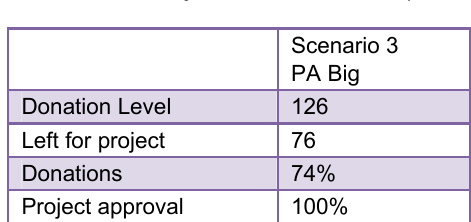
Figure 7 – Risk Map model for “back-propagation” scenario 3 Рис . 7 – Карта рисков по сценарию 3 ( снизу вверх ) Слика 7 – Мапа ризика за сценарио 3 ( одздо на горе ) Table 4 – Data after running scenario 3 Таблица 4 – Полученные данные по сценарию 3 Табела 4 – Добијени подаци за сценарио